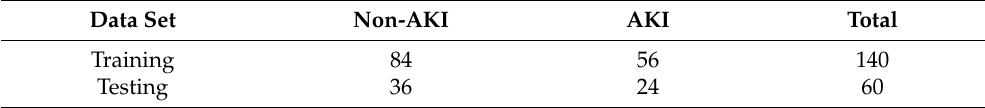
Table 1. Classification of all tested urine samples under Raman spectroscopy: Training set and test